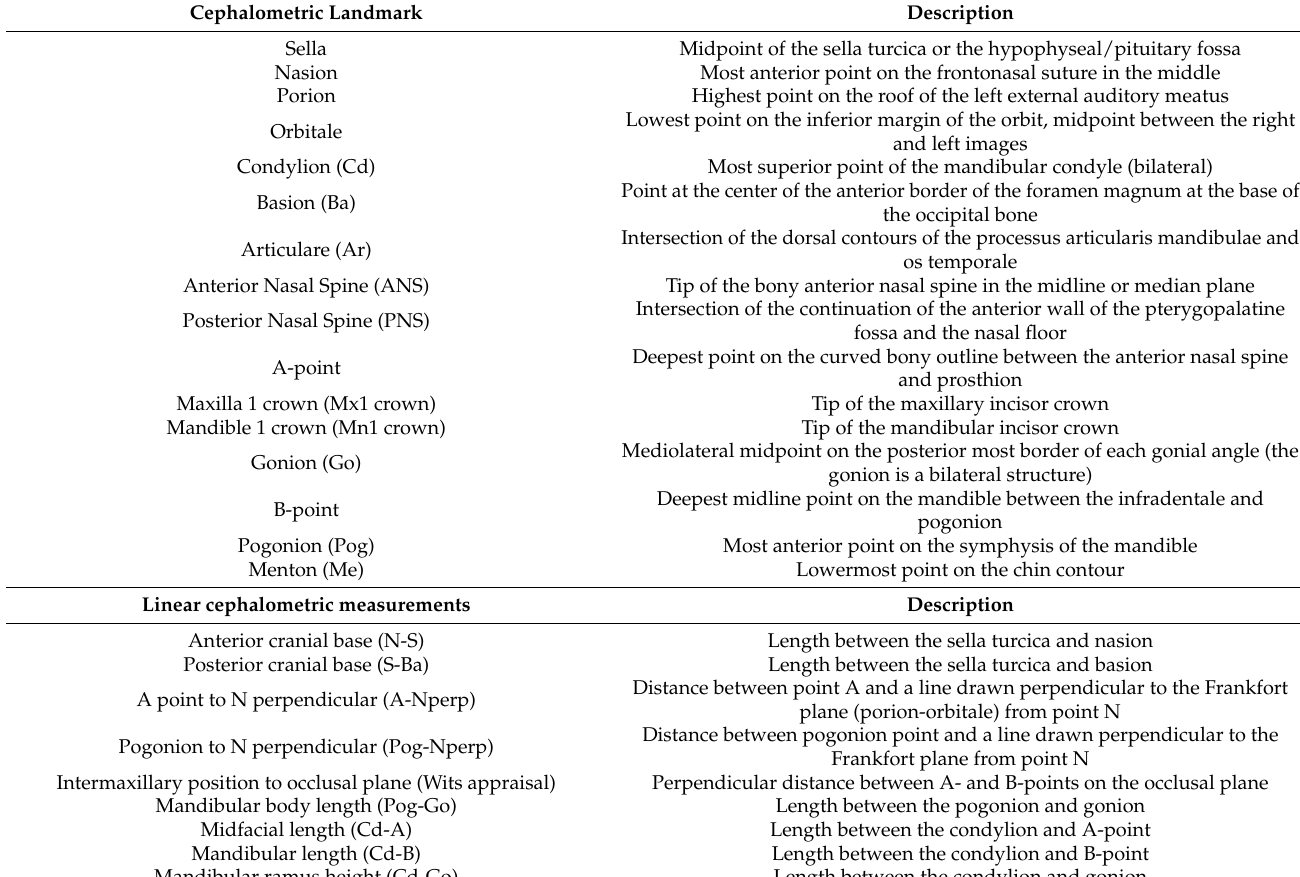
Figure 3. Angular measurements used in this study. 1, SN to the FH plane; 2, SNA angle; 3, SNB angle; 4, ANB angle; 5, saddle angle; 6, articular angle; 7, gonial angle; 8, SN-GoGn; 9, AB to the mandibular plane; 10, A–B plane angle; 11, facial axis; 12, mandibular plane angle; 13, A-B to the occlusal plane; 14, inclination of upper incisor; and 15, inclination of lower incisor. Table 1. Descriptions of cephalometric landmarks, linear, and angular